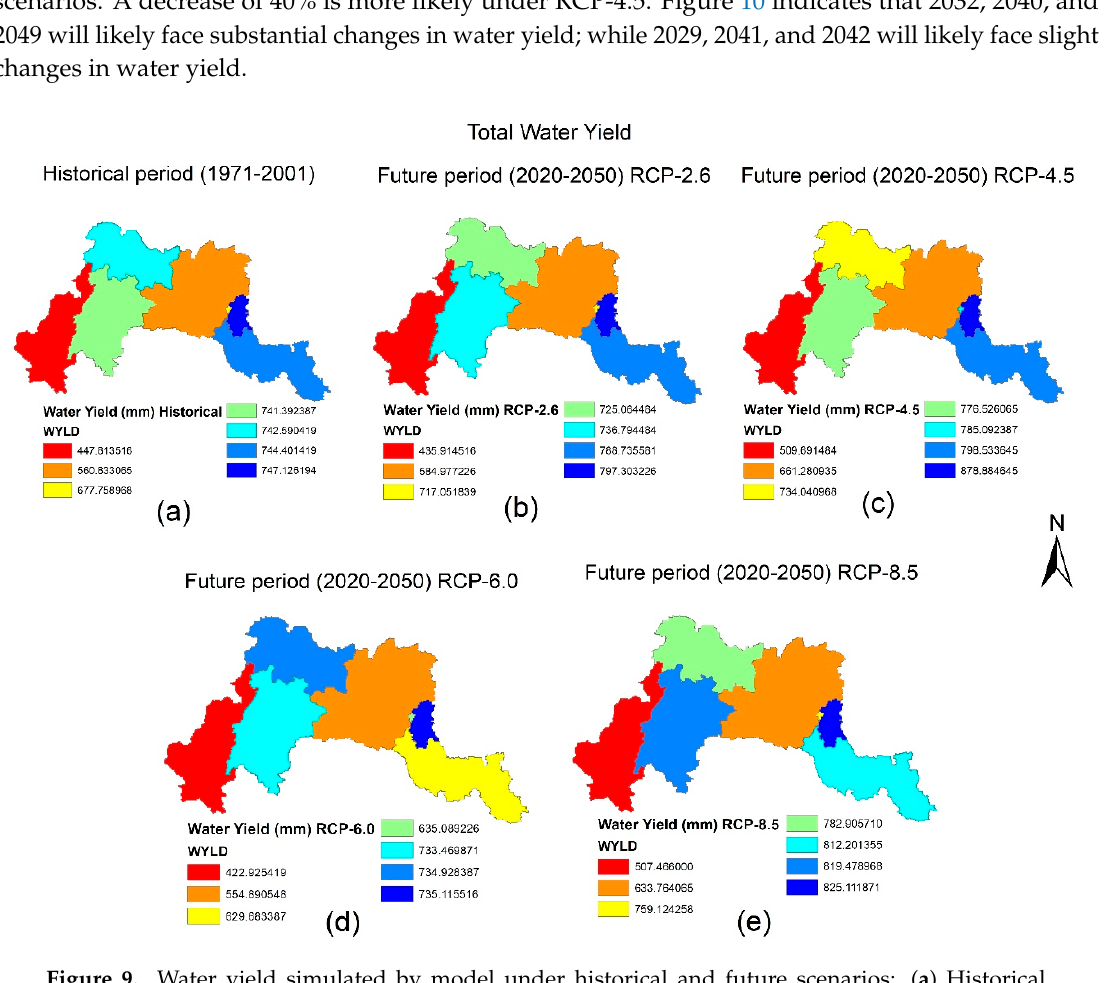
Table 9. Annual average historical (1971–2001) and future (2020–2050) water balance components for the entire watershed.